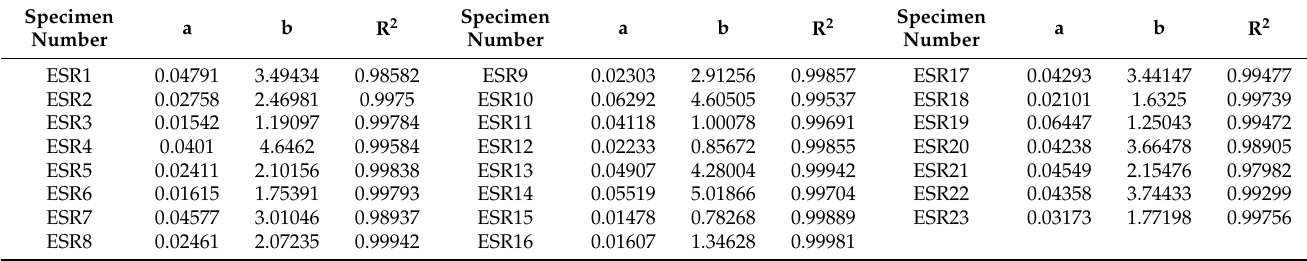
Table 3. Regression analysis constants a and b for Equation (4)—H-D